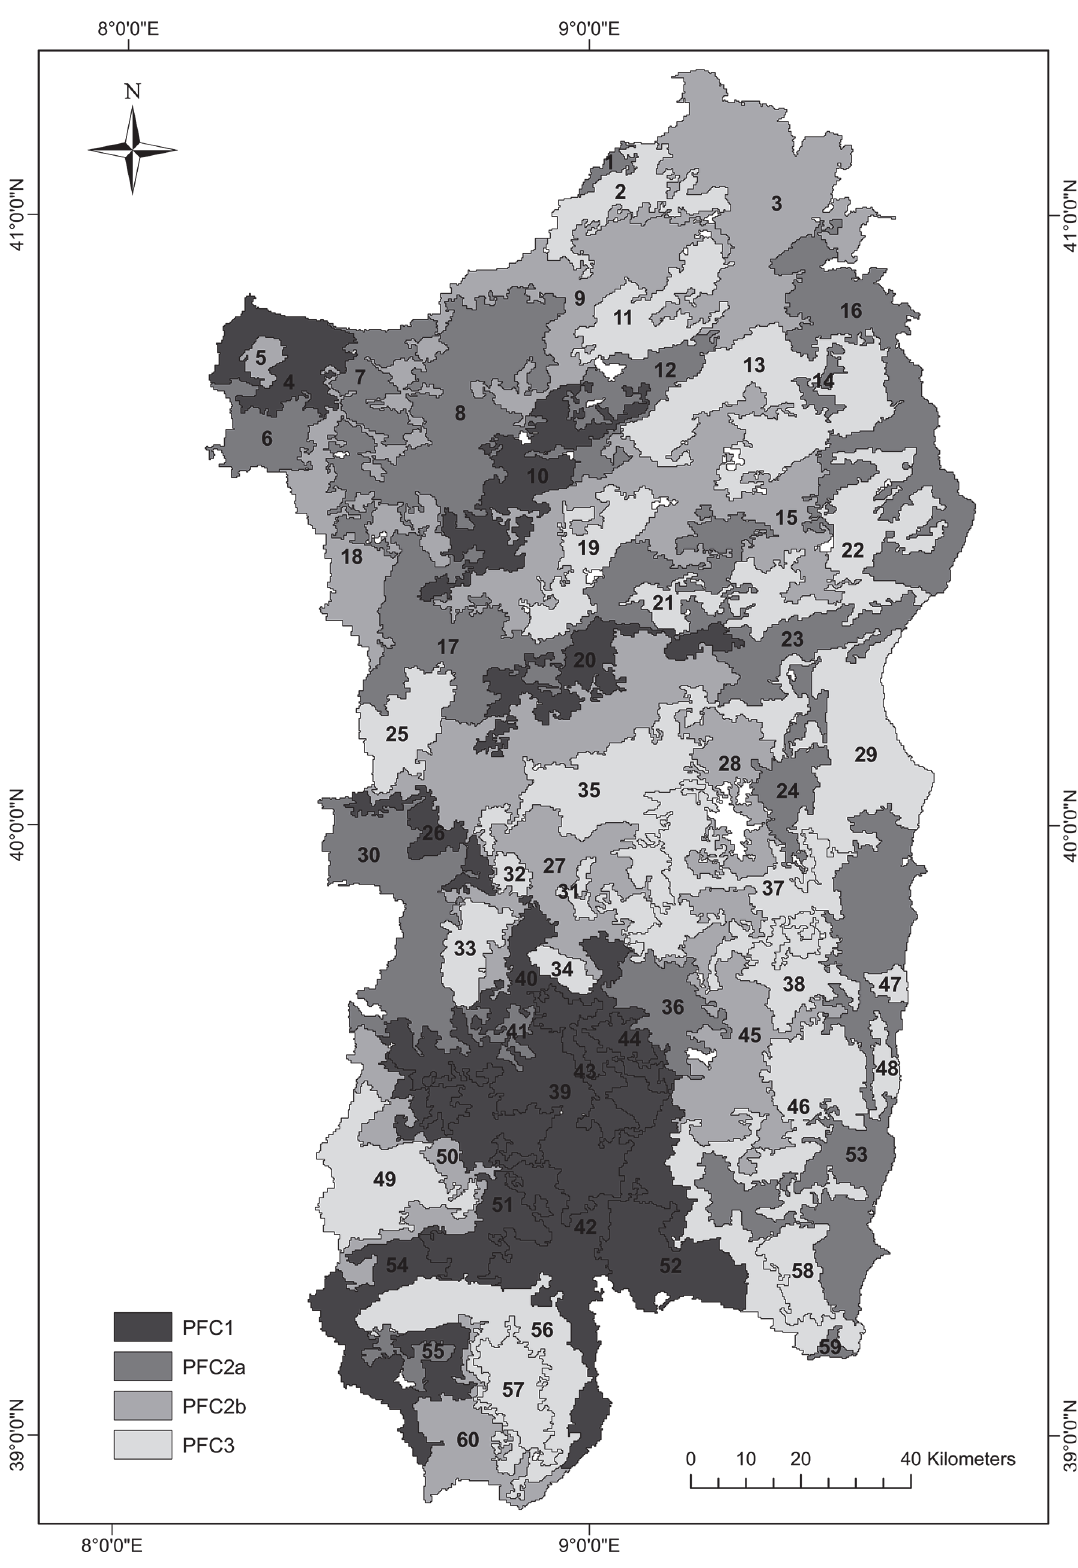
Fig 1. Spatial distribution of the 60 phenological units (PUs) and of the four phenological fuel classes (PFCs).